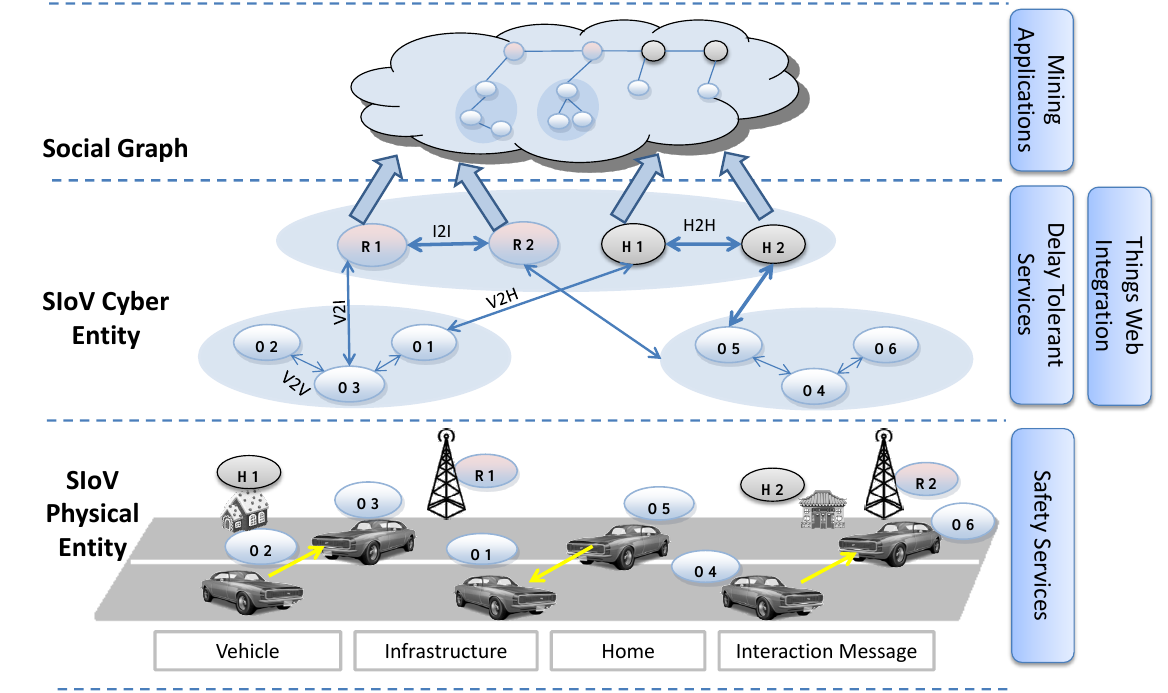
Figure 1. Architecture of Social Internet of